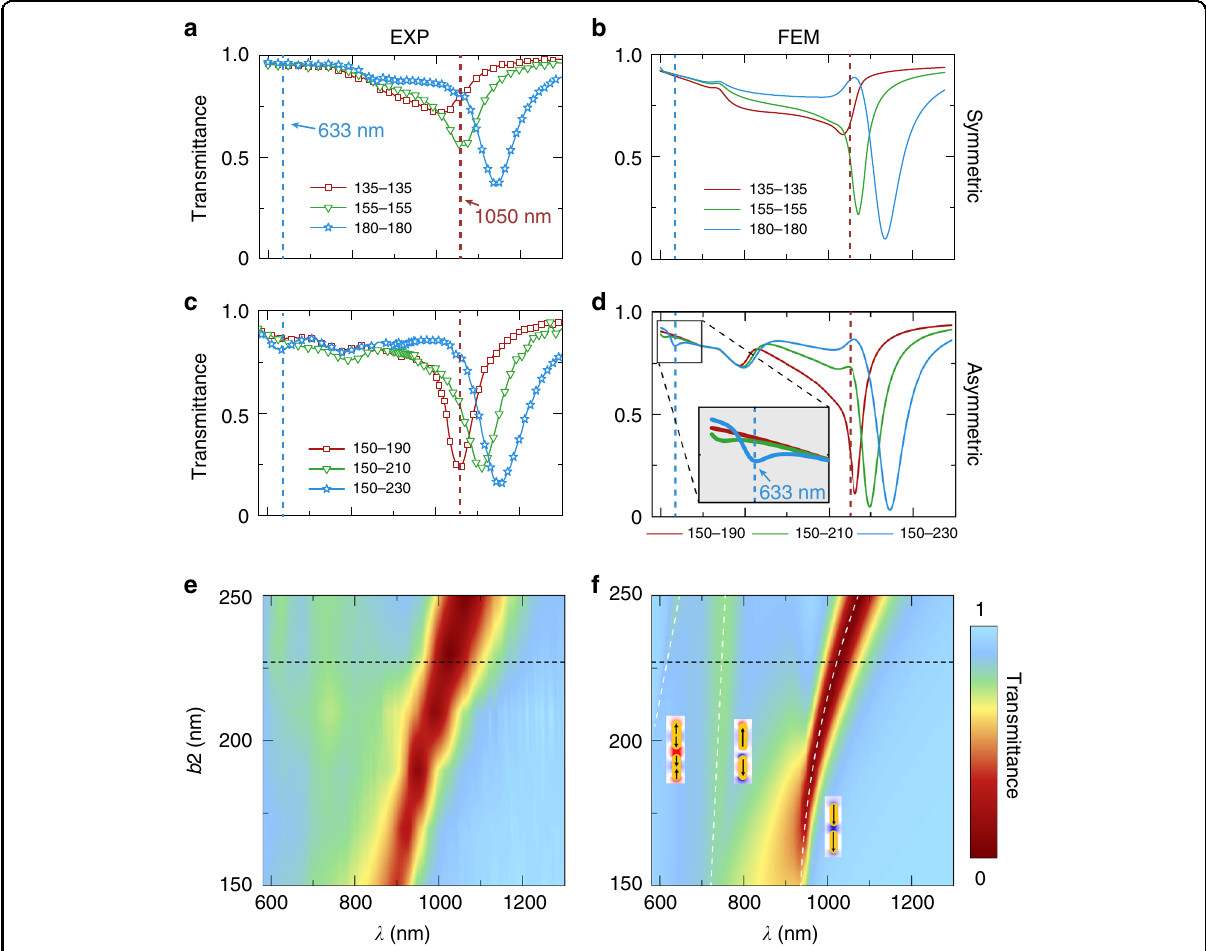
Fig. 3 Measured and simulated transmission spectra of nano-antenna arrays. a, b Measured and simulated transmittance spectra of the symmetric samples. c, d Measured and simulated transmittance spectra of the asymmetric samples. e, f Measured and simulated transmittance versus b 2 and wavelength for the asymmetric samples. From right to left, Fig. 3f insets shows the binding, anti-binding mode of dipolar resonance, and the binding mode of quadrupole mode. The anti-binding modes of quadrupole resonance are at wavelengths shorter than 600 nm (not shown). Black dash line denotes the position of b 2 = 227 nm . White dashed lines denote the evolutions of resonant modes in such nano-antennas with insets schematically depicting the current distributions of the